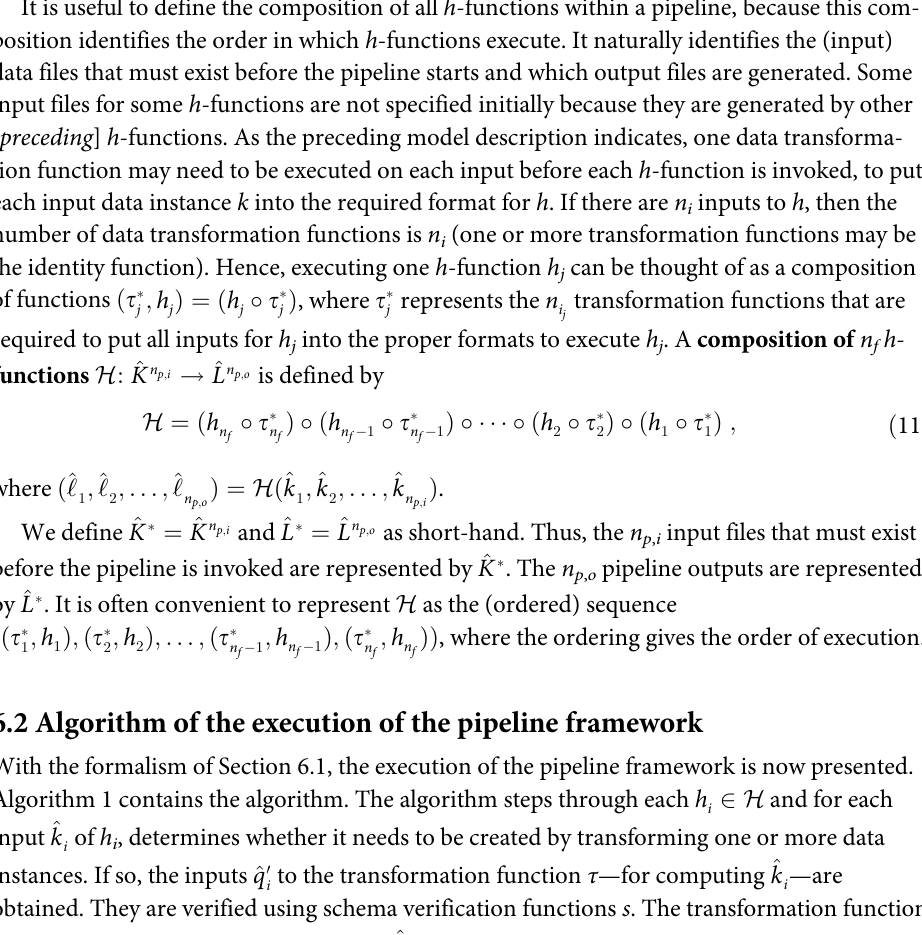
Algorithm 1 Steps of the Algorithm P IPELINE E XECUTION . Algorithm 1 : P IPELINE E XECUTION